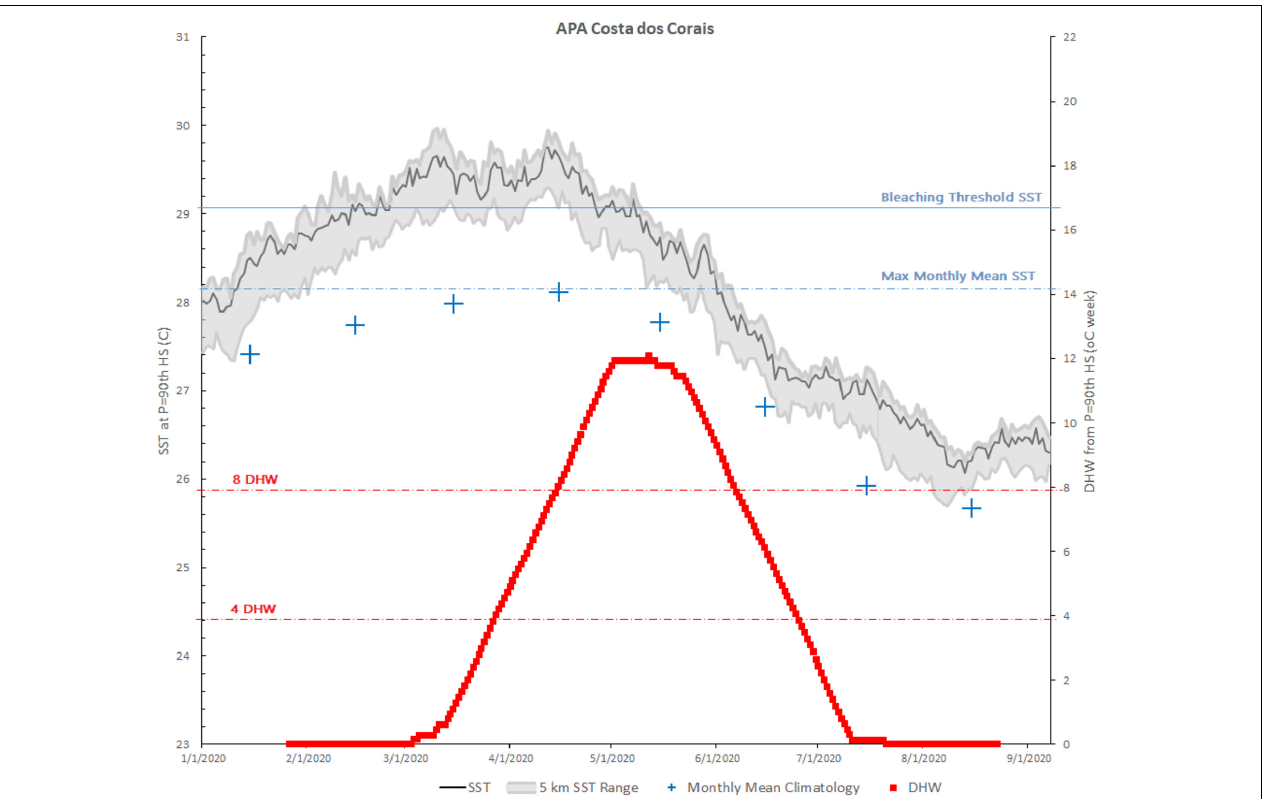
FIGURE 2 | Sea surface temperature (SST) and degree heating week (DHW) for the marine protected area (MPA) Costa dos Corais Regional Virtual Station (CCRVS) from February 8 to July 30,